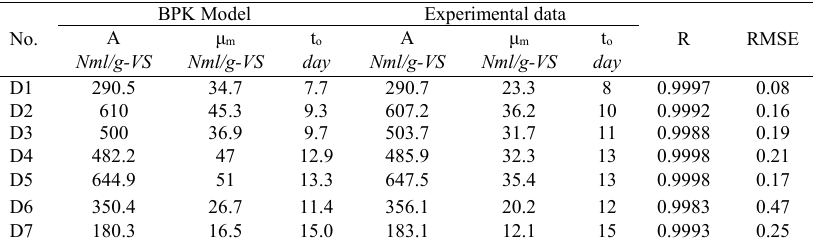
Table 4: Characteristics of gas production kinetics